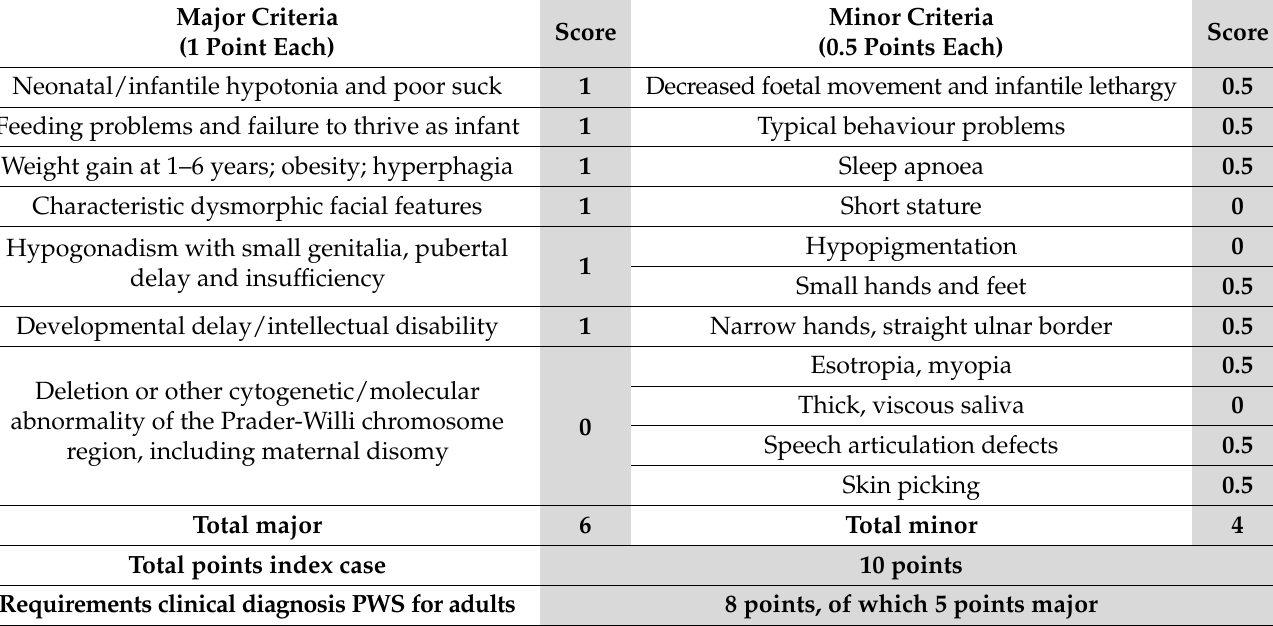
Table 1. Consensus criteria Prader–Willi syndrome and the score of the index